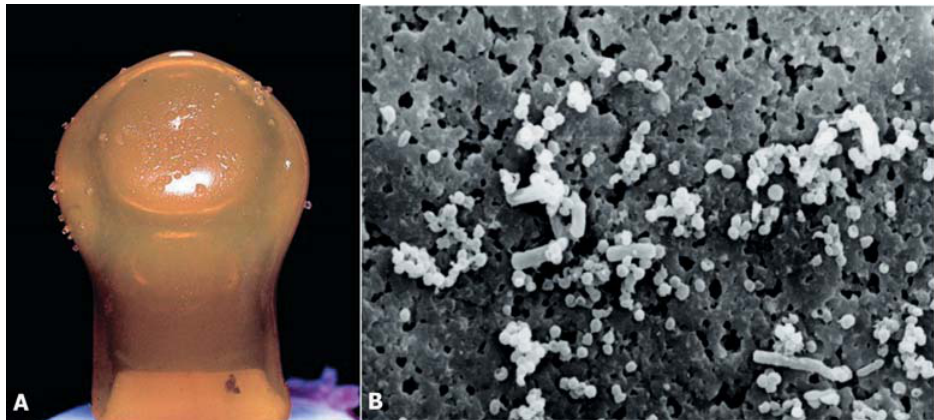
Figure 2- Brushtox ® (cid:3)(cid:16)(cid:3)(cid:38)(cid:82)(cid:79)(cid:82)(cid:81)(cid:76)(cid:72)(cid:86)(cid:18)(cid:69)(cid:76)(cid:82)(cid:191)(cid:79)(cid:80)(cid:86)(cid:3)(cid:82)(cid:73)(cid:3) Mutans streptococci after microbial culture (A) and scanning electron microscopy micrograph (B)